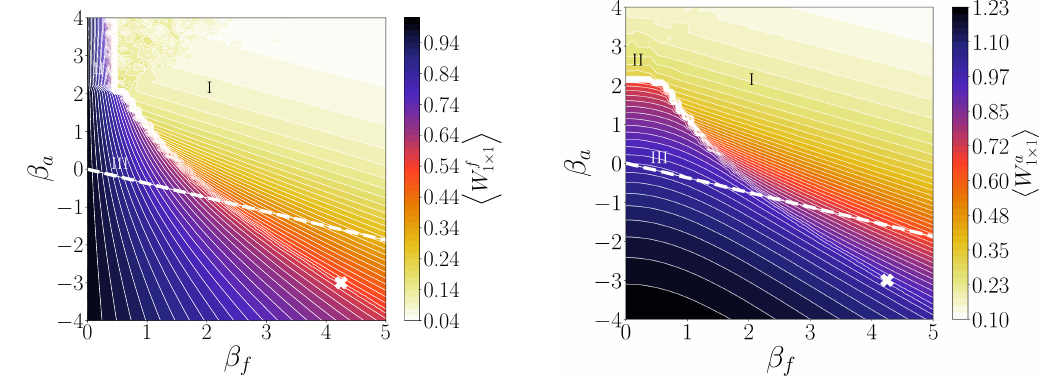
(cid:10) (cid:11) W f 1 × 1 β f ,β a < 0 and above g 2